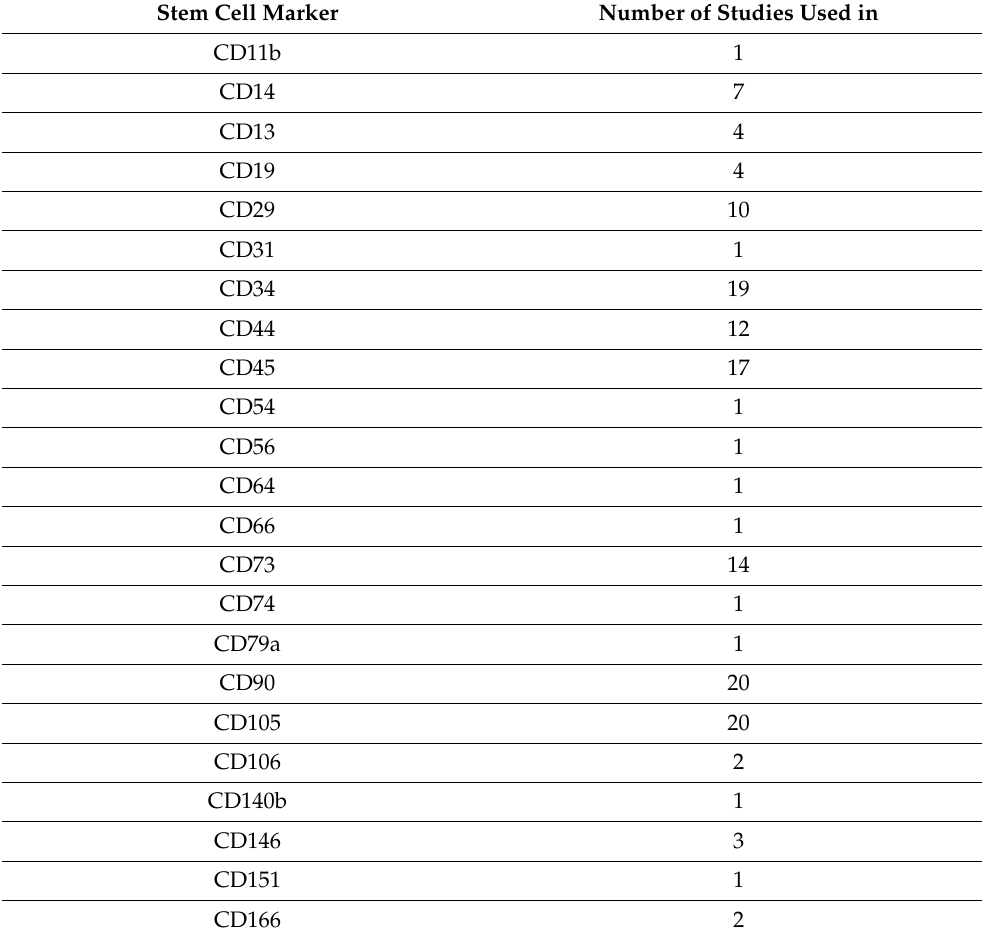
Table 3. MSC markers used across all studies included in this review and the frequency of studies using each